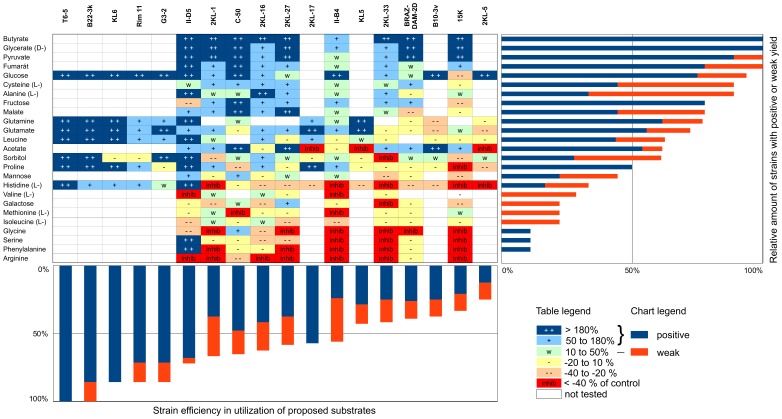
Metabolic characteristics of newly isolated Limnohabitans spp. and described species.The characteristics of L. australis strain MWH-BRAZ-DAM-2D, L. curvus MWH-C5, L. parvus II-B4 and L. planktonicus II-D5 were taken from [4], [6] and [7], respectively. Biomass increase of strains was scored as++(highly positive, >180% of control treatments),+(positive, 50–180%), w (weak, 10–50%), − (no growth, -20–10%), – (light inhibition, −40–−20%) and inhib (severe inhibition,<-40%). Strains and substrates are sorted according to their relative number of hits when growth growth was observed (<20% biomass increase), i.e. more opportunist on the left and more specialist on the right, and more preferred substrate on the top and less on the bottom.